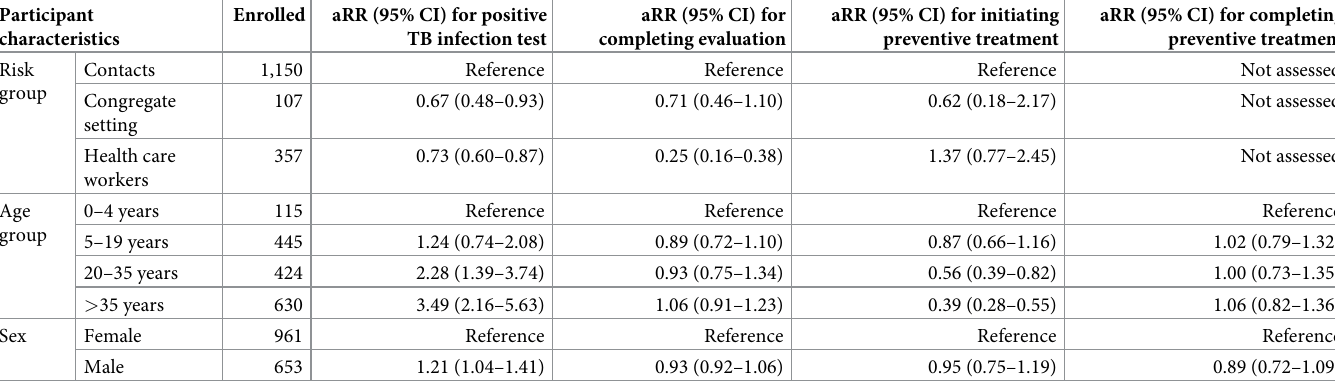
Table 2. Predictors of TB infection, evaluation, preventive treatment initiation, and preventive treatment completion. Participant